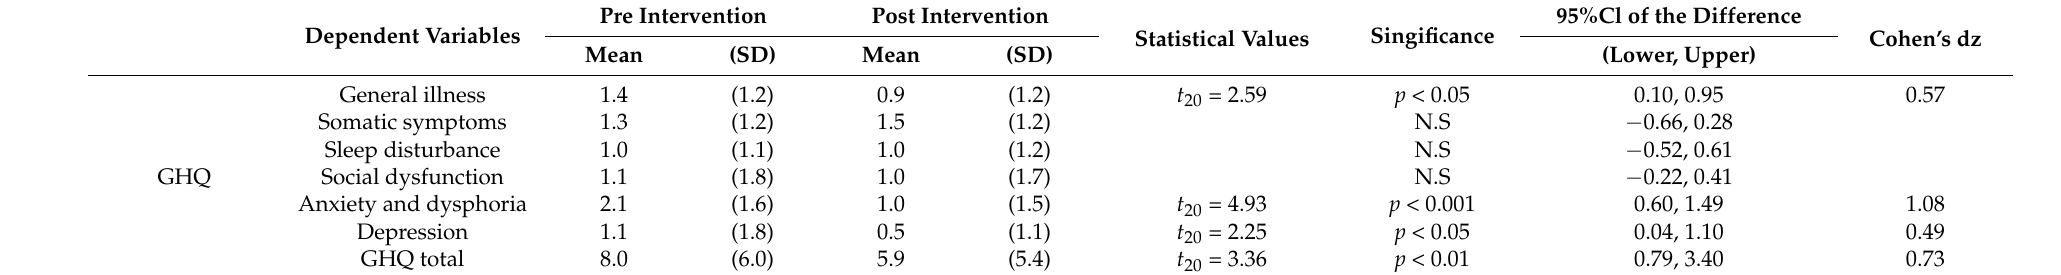
Table 2. Means and standard deviations of GHQ scores pre- and